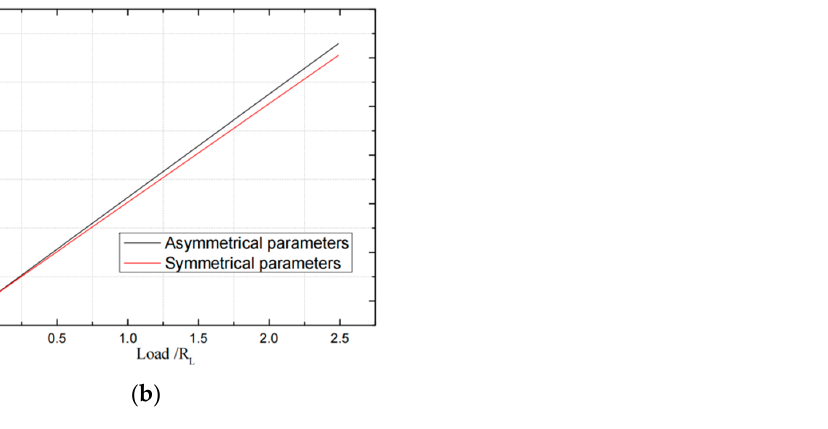
Figure 15. Transmission power characteristic curve of dual-LCC system under different parameters: ( a ) transmission power—coupling coefficient, ( b ) transmission power—load.